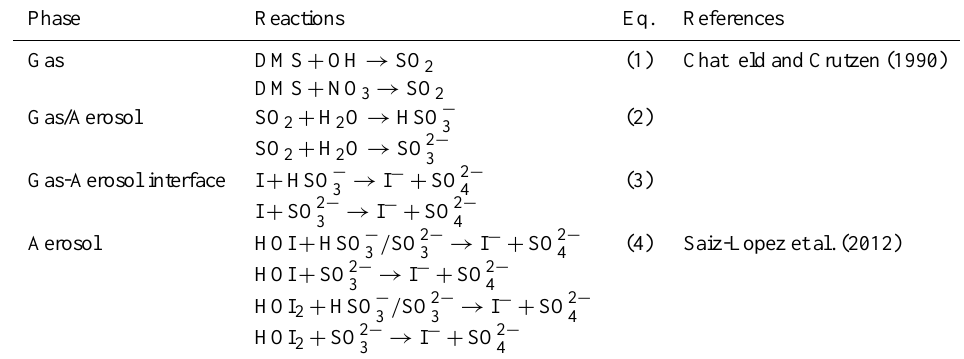
Table 3. Possible pathways of formation of iodide by reduction of sulfur compounds.